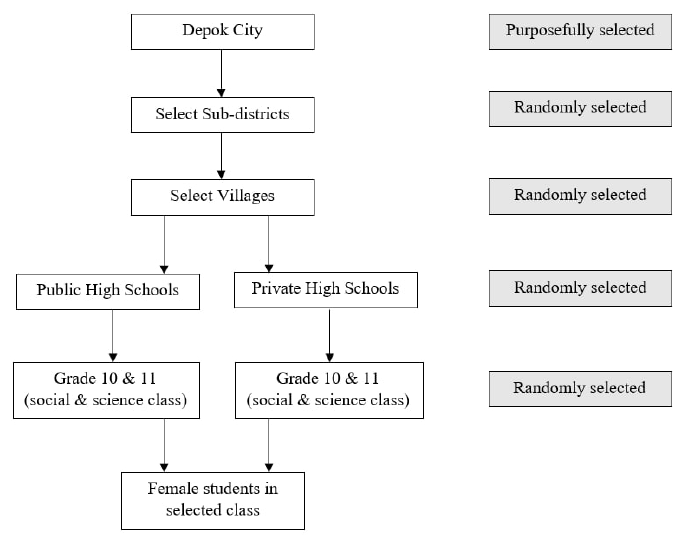
Figure 1 . Sampling procedure